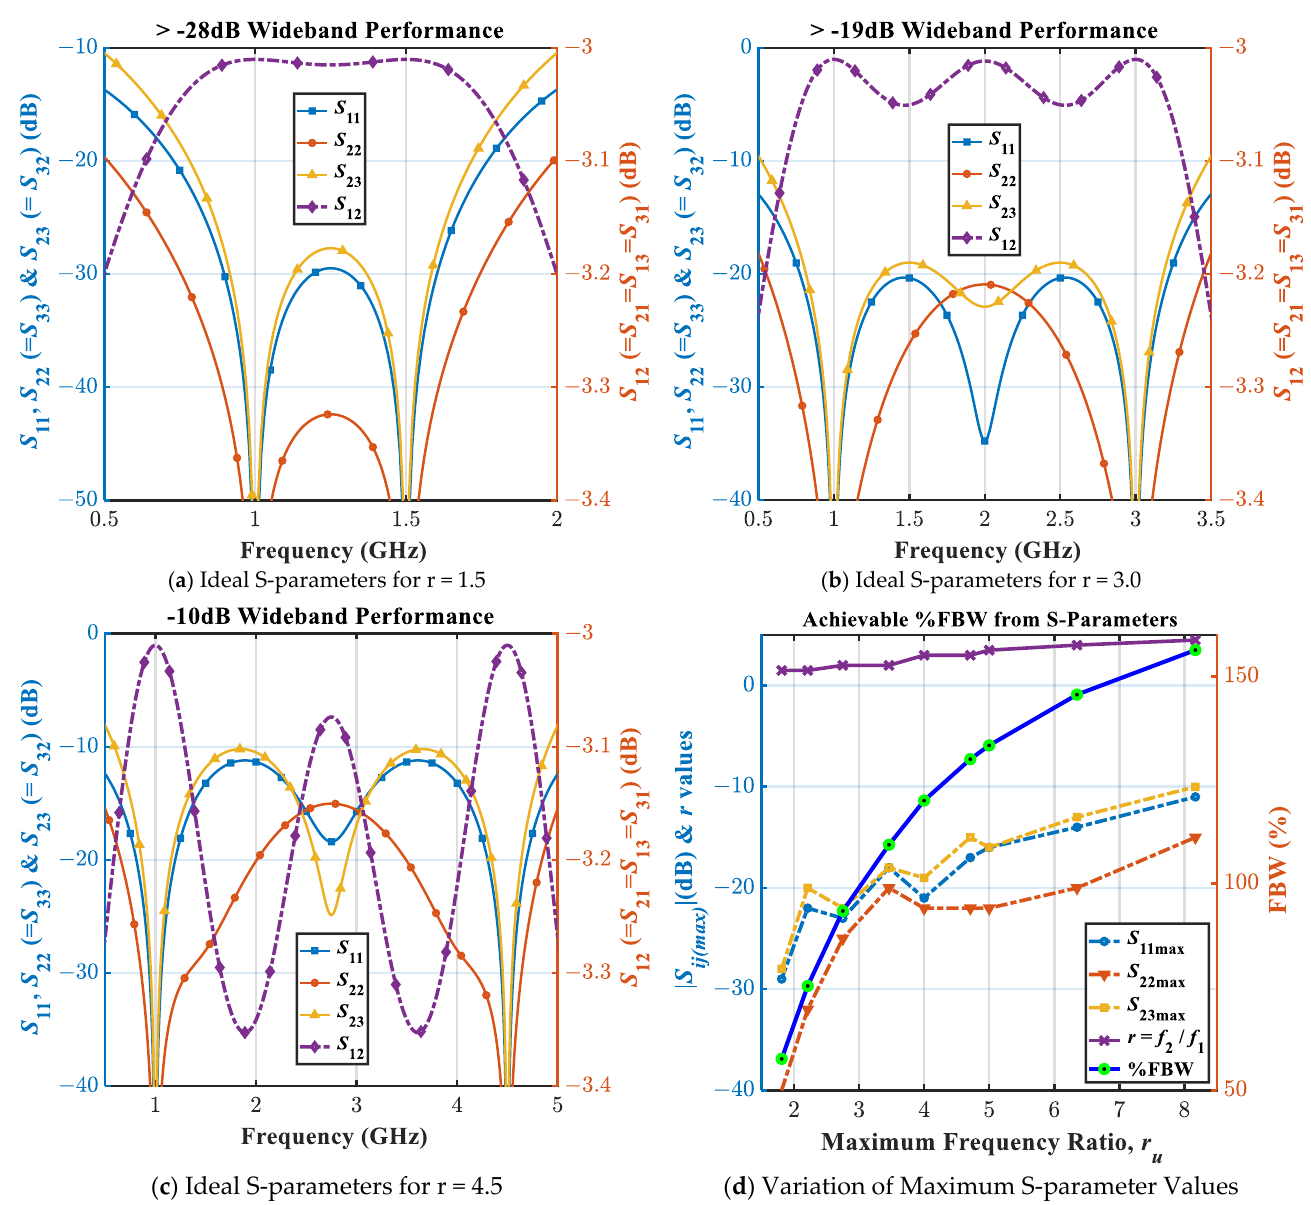
Figure 8. Ideal S-parameters with the variation of r , r u, and %FBW.